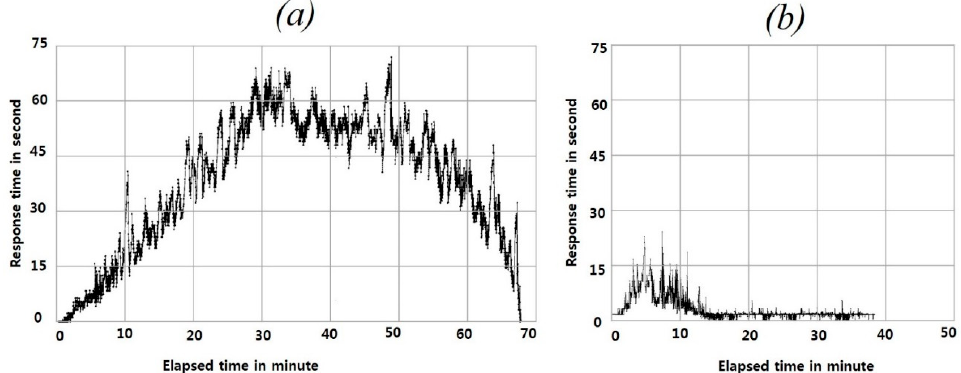
Figure 4. Performance measurement with the binary thresholding algorithm in a cloud computing environment: ( a ) single virtual server without auto-scaling; ( b ) auto-scaled virtual servers.